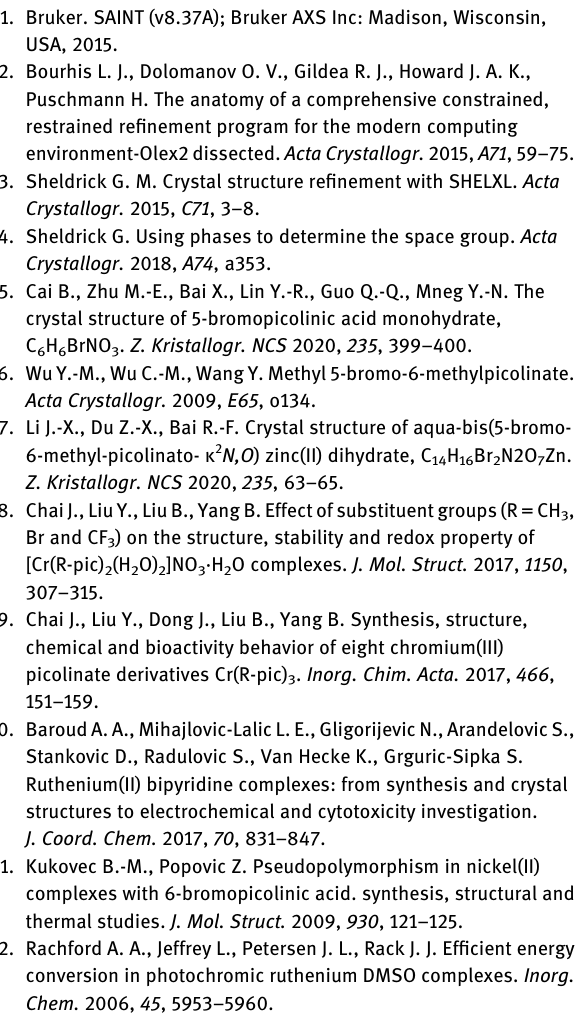
been reported. Herein we reported the crystal structure of 3-bromopicolinic acid. The asymmetric unit is made of two 3-bromopicolinic acid molecules, which show a slightly different confor-